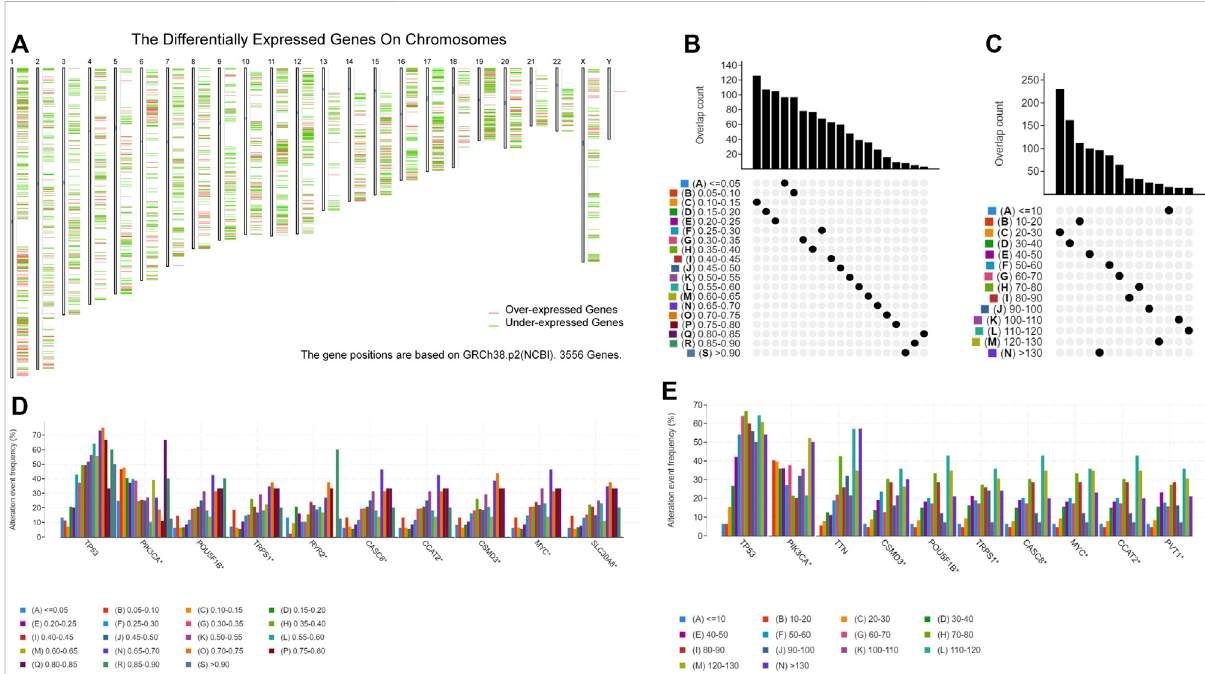
FIGURE 1 Identi fi cation of potential tumor-associated antigens of breast cancer (BC). (A) Chromosomal distribution of upregulated and downregulated genes in BC. (B) Overlapping samples in the altered genome fraction group. (C) Overlapping samples in the mutation count group. (D) Highest average frequency genes in the fraction genome altered genome. (E) Highest average frequency genes in the mutation count